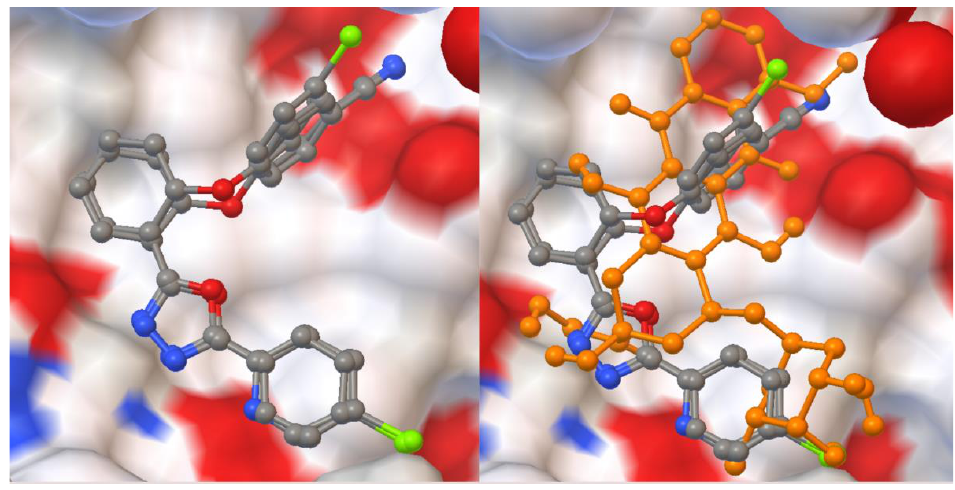
Figure 6. Interaction of the best-docked poses of compounds 4g , 4h , 4l , and reference drug doxoru- bicin to 1Z5M target.